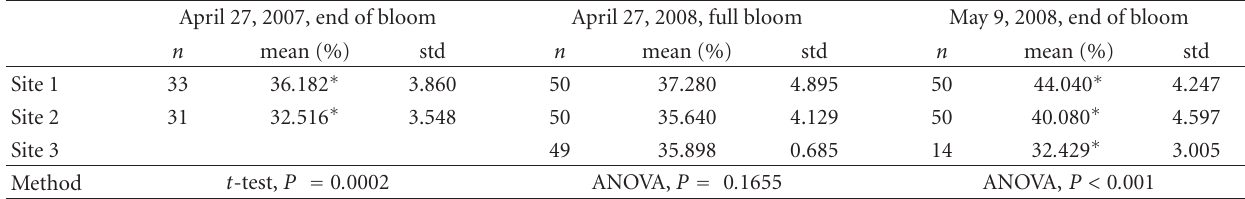
Table 6: The e ff ect of habitat on nectar